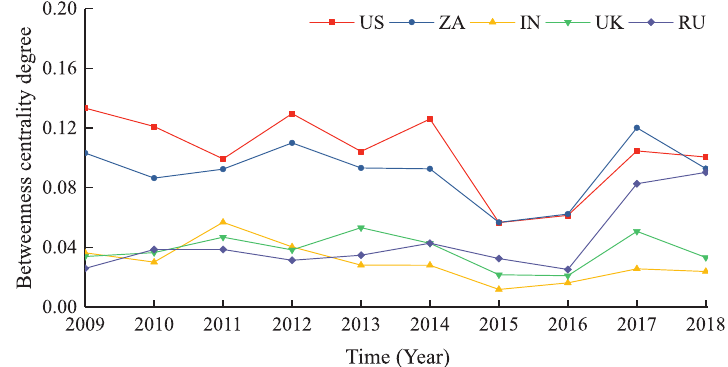
Figure 10. Evolution of the ranking of major trading